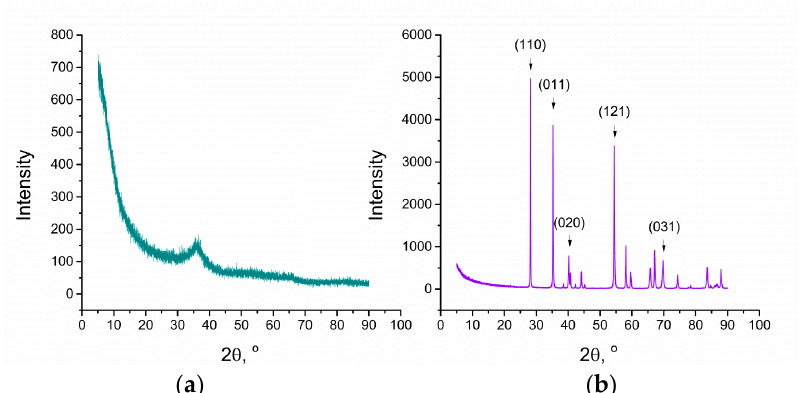
Figure 2. X-ray di ff ractogram of ( a ) hydrous RuO 2 and ( b ) anhydrous RuO 2 . Figure 2. X-ray diffractogram of ( a ) hydrous RuO Figure 2. X-ray diffractogram of ( a ) hydrous RuO 2 and ( b ) anhydrous RuO 2 . 2 and ( b ) anhydrous RuO 2 .